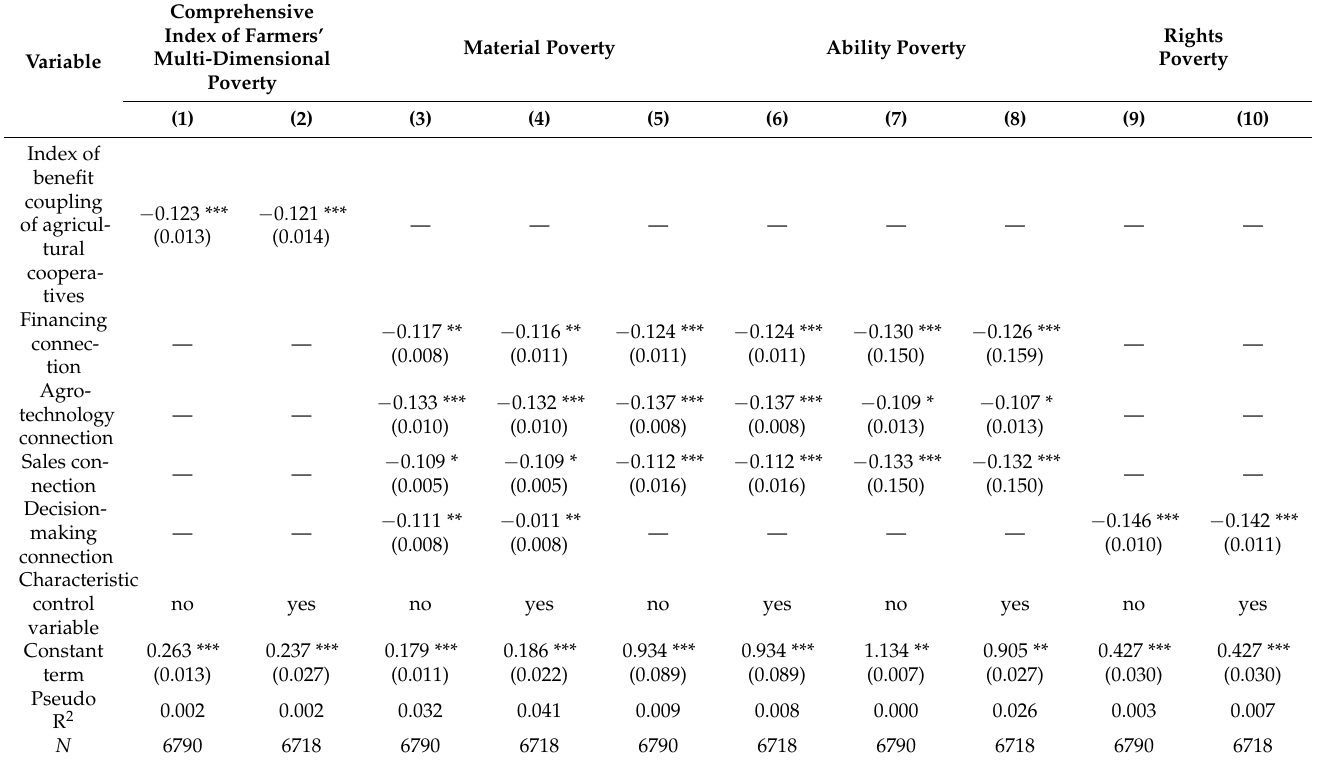
Table 3. The multidimensional poverty reduction effect of benefit coupling: OLS